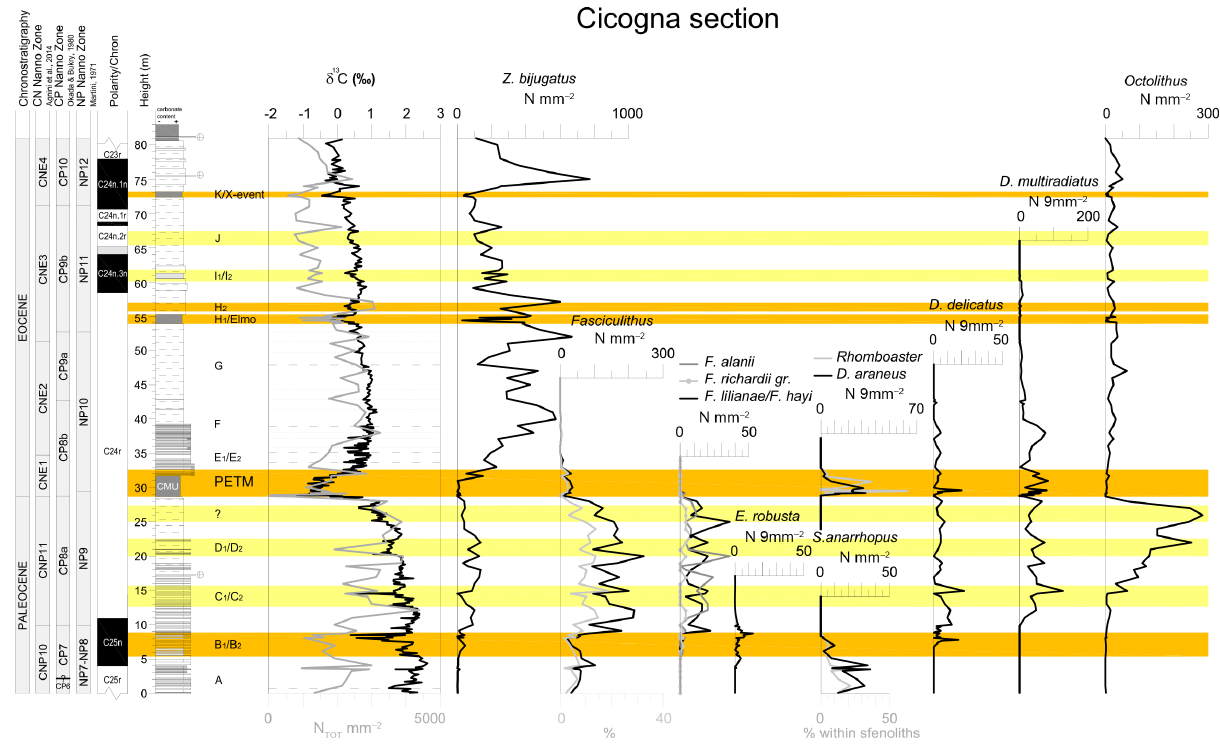
Figure 8. Relative (%) and semi-quantitative (Nmm − 2 ) abundances of selected, mainly late Paleocene, calcareous nannofossil taxa across the Cicogna section. Also shown are the lithostratigraphy, magnetostratigraphy, biostratigraphy and carbon isotope ( δ 13 C) stratigraphy at the Cicogna section (Fig. 4). Color bands and symbols are the same as in previous figures.